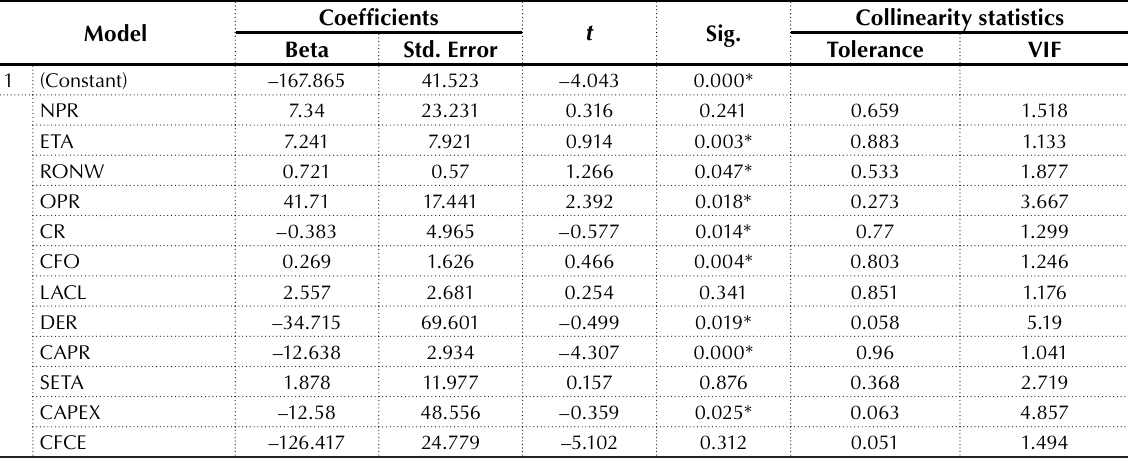
Table 9. Regression coefficients of independent